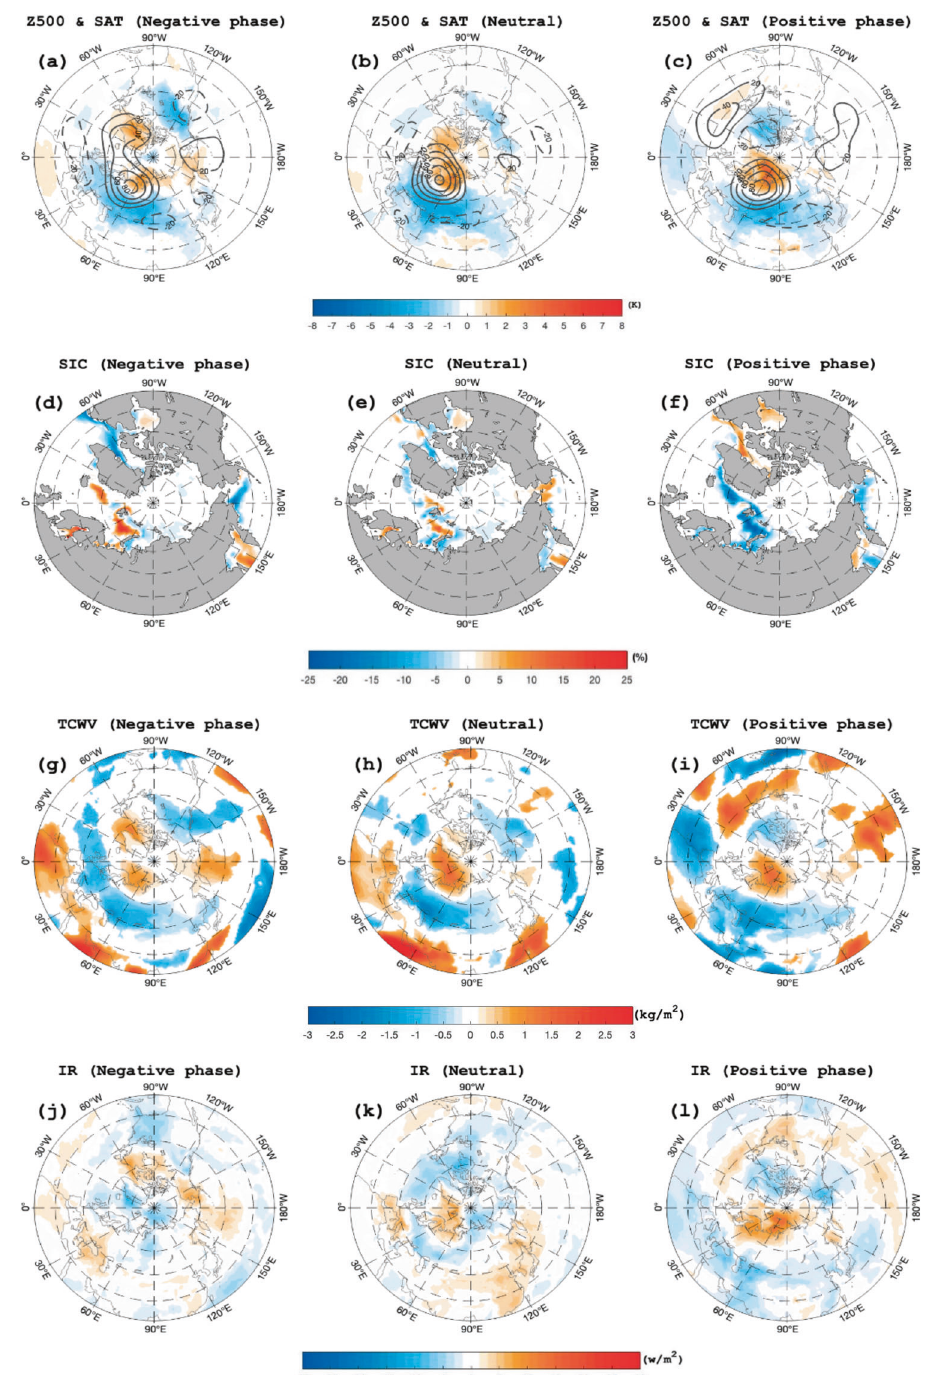
anomalies averaged from lag − 10 to 10 days of UB events for a , d , g , j negative, b , e , h , k neutral,and c , f , i , l positivephasesof9-yearhigh-pass fi lterednormalized DJF(December-February)mean NorthAtlanticSST fi rst principalcomponent(PC1) time series during 1950 – 2019. Lag 0 denotes the peak day of the UB and the color shaded areas are signi fi cant at the 5% level based on a two-sided Student t